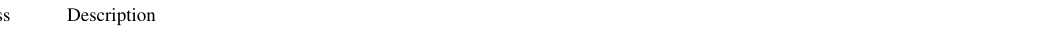
Table C1. Classification of logged data